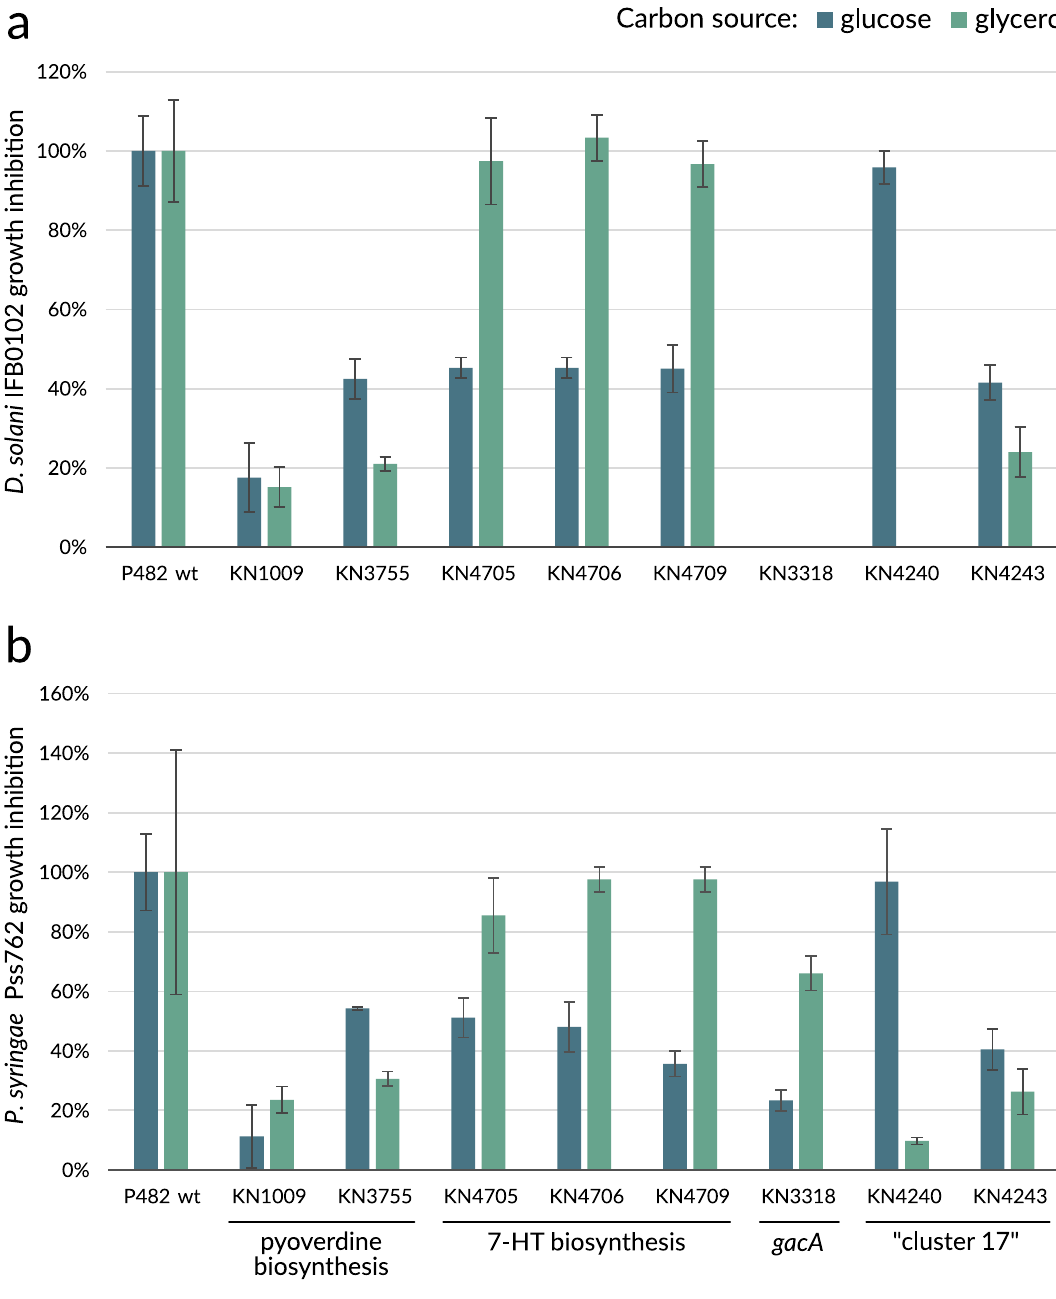
Figure 1. Growth inhibition of Dickeya solani IFB0102 ( a ) and Pseudomonas syringae pv. syringae Pss762 ( b ) by Pseudomonas donghuensis P482 mutants tested on minimal M9-agar medium with 0.4% glucose or 0.4% glycerol as a sole carbon source. The bars represent the percentage of the growth inhibition zone obtained for P482 wt under given conditions. Pseudomonas vranovensis DSM16006 T does not cause growth inhibition of the tested pathogens and was used as a negative control strain (see Supplementary Data Figure S1). The assay was performed in triplicates; error bars represent standard